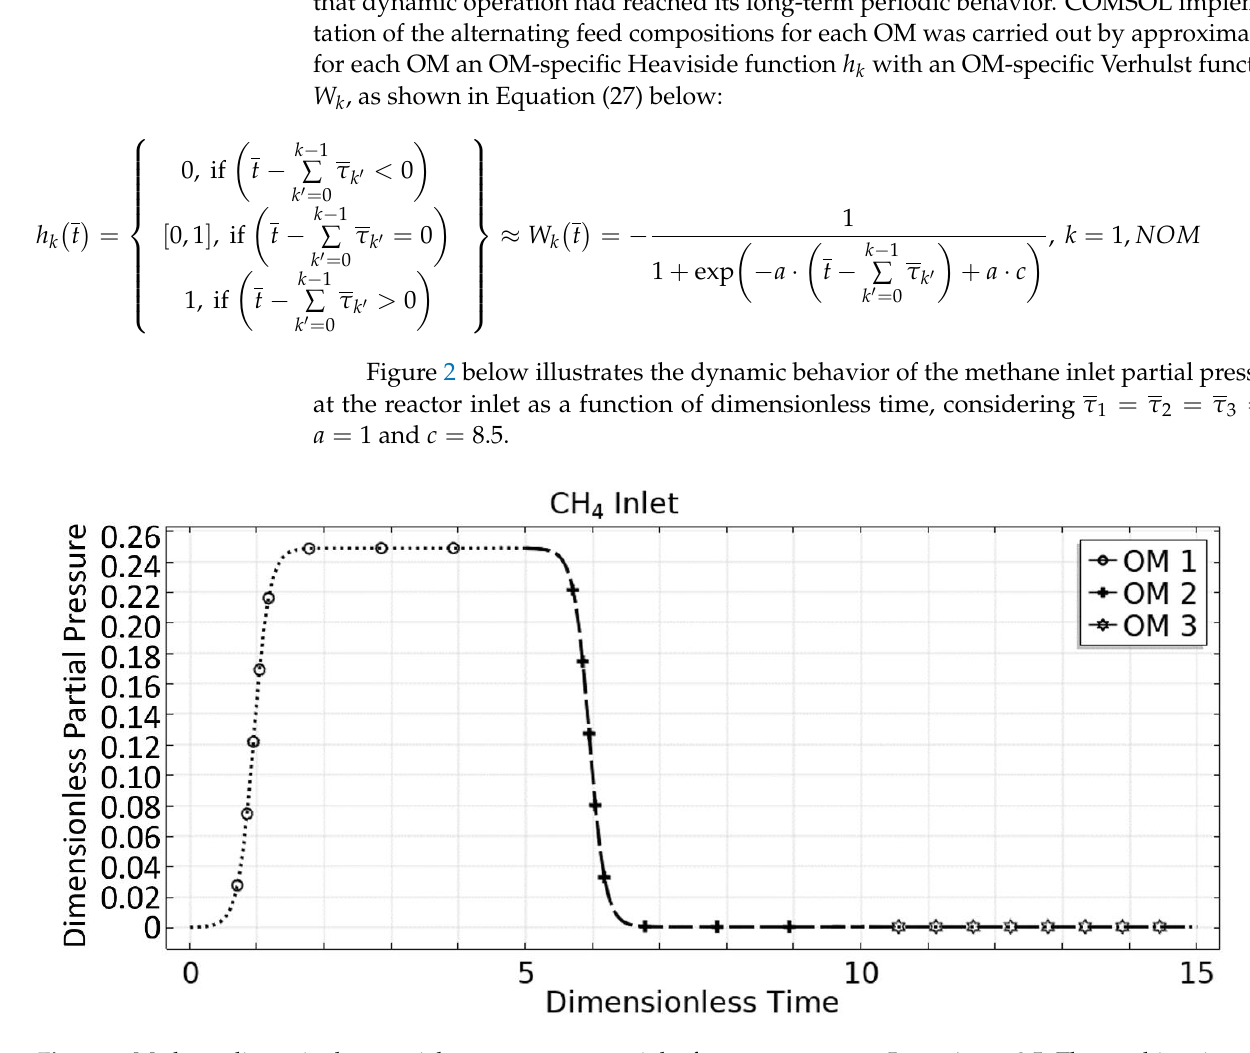
Figure 2. Methane dimensionless partial pressure at reactor inlet for τ 1 = τ 2 = τ 3 = 5, a = 1, c = 8.5. The resulting time evolution of SMR-MSR state variables for the seventh trial ( D a = 2, Θ = 10) is displayed in the figures below.